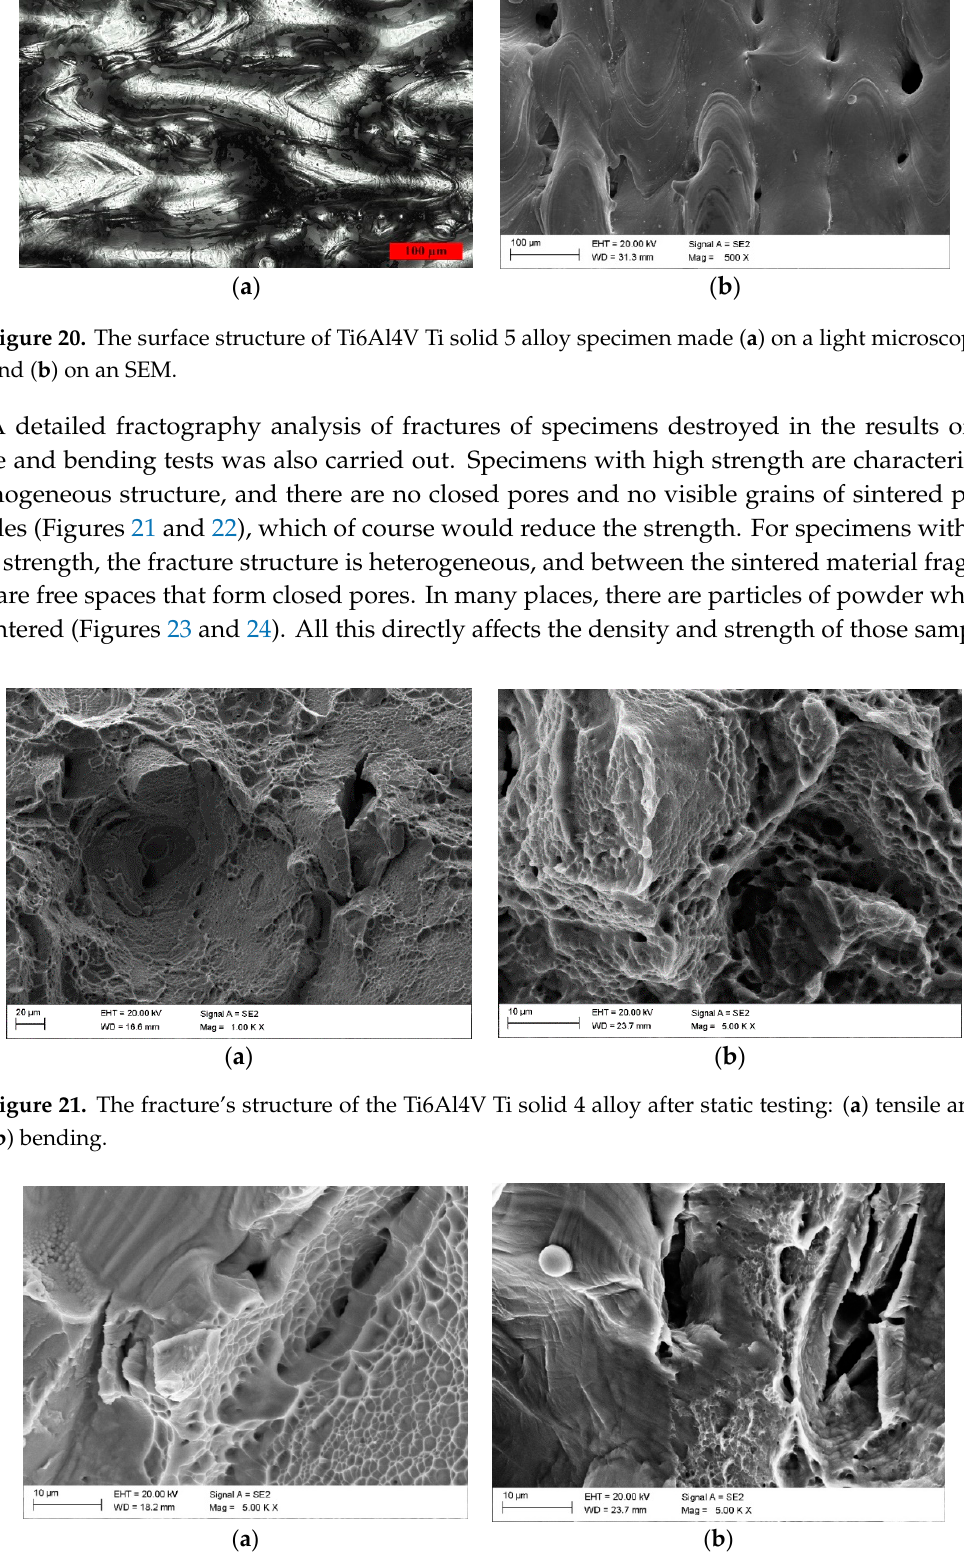
Figure 22. The fracture’s structure of the Ti6Al4V Ti solid 1 alloy after static testing: ( a ) tensile and ( b ) bending.